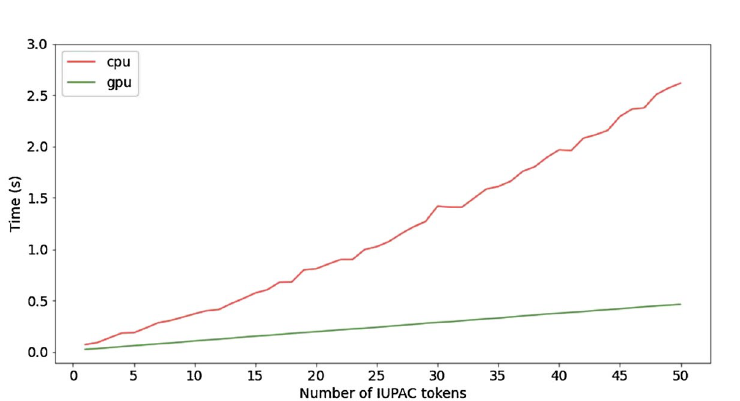
Figure 6. The correlation of mean time and output sequence